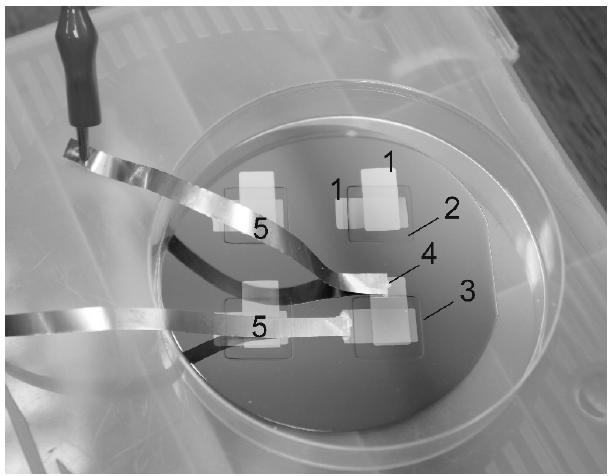
Figure 1. Experimental cells Pt(100 nm)/LiPON(1 µm)/Pt(100 nm): 1 —platinum electrodes; 2 —1 micron thick LiPON film; 3 —silicon dioxide; 4 —conductive glue; 5 —copper foil down conductors.